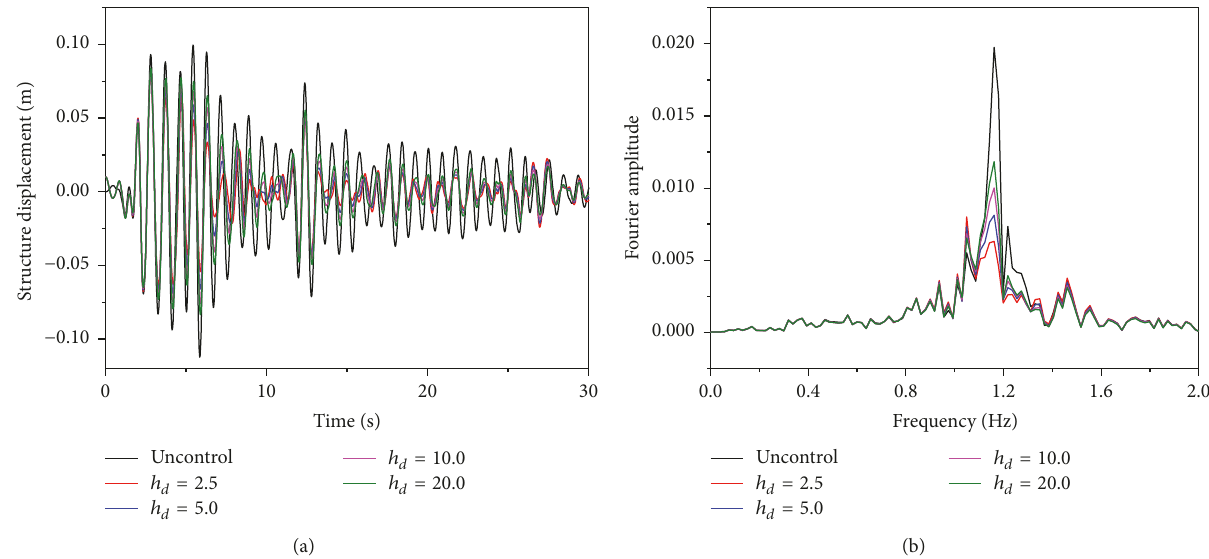
Figure 12: Comparison of mitigation effects with different head loss coefficient for (a) time histories of the structure displacement and (b) Fourier amplitude of the structure response.